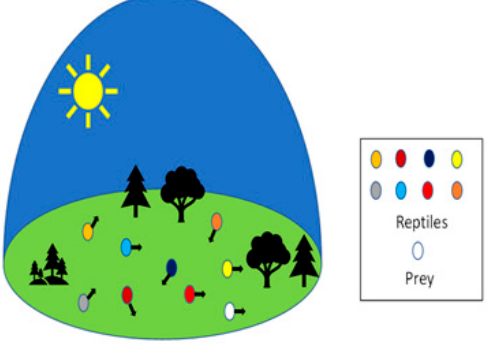
Figure 2. Encircling prey (t ≤ T/2).